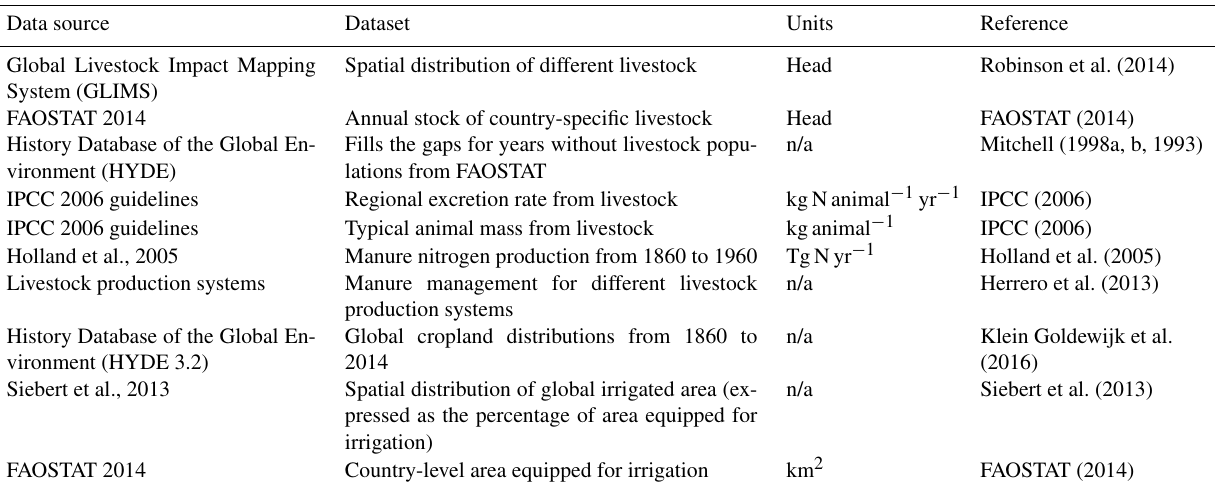
Table 1. Summary of data sources used in this